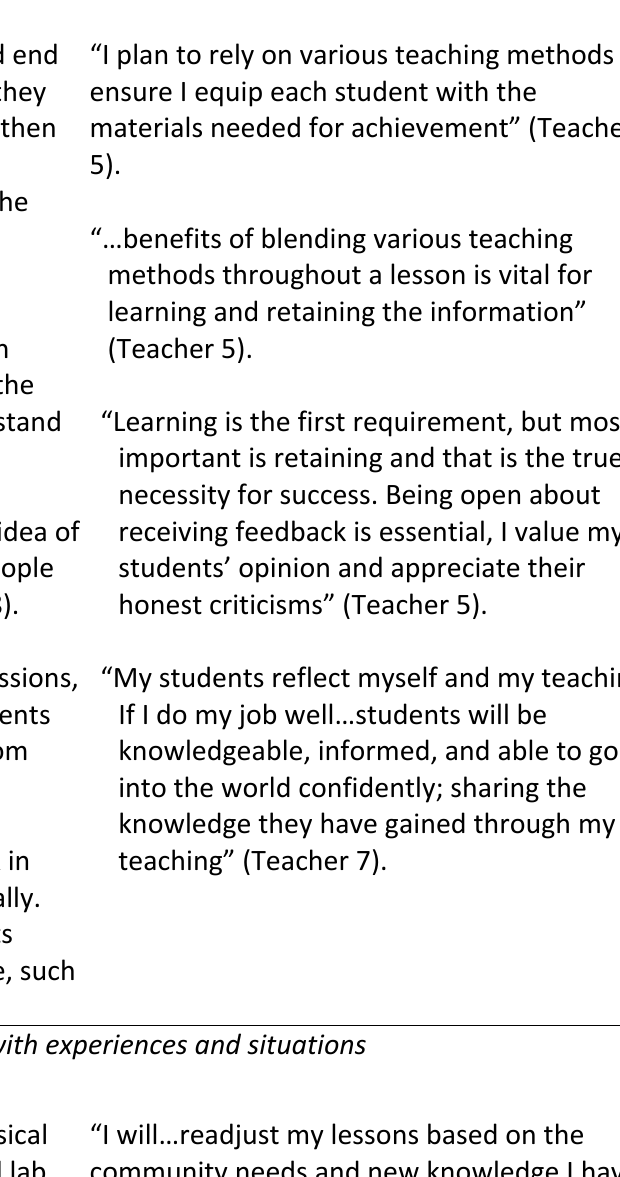
Comparing Teaching Philosophy Statements of Preservice Teachers and Their Preferred